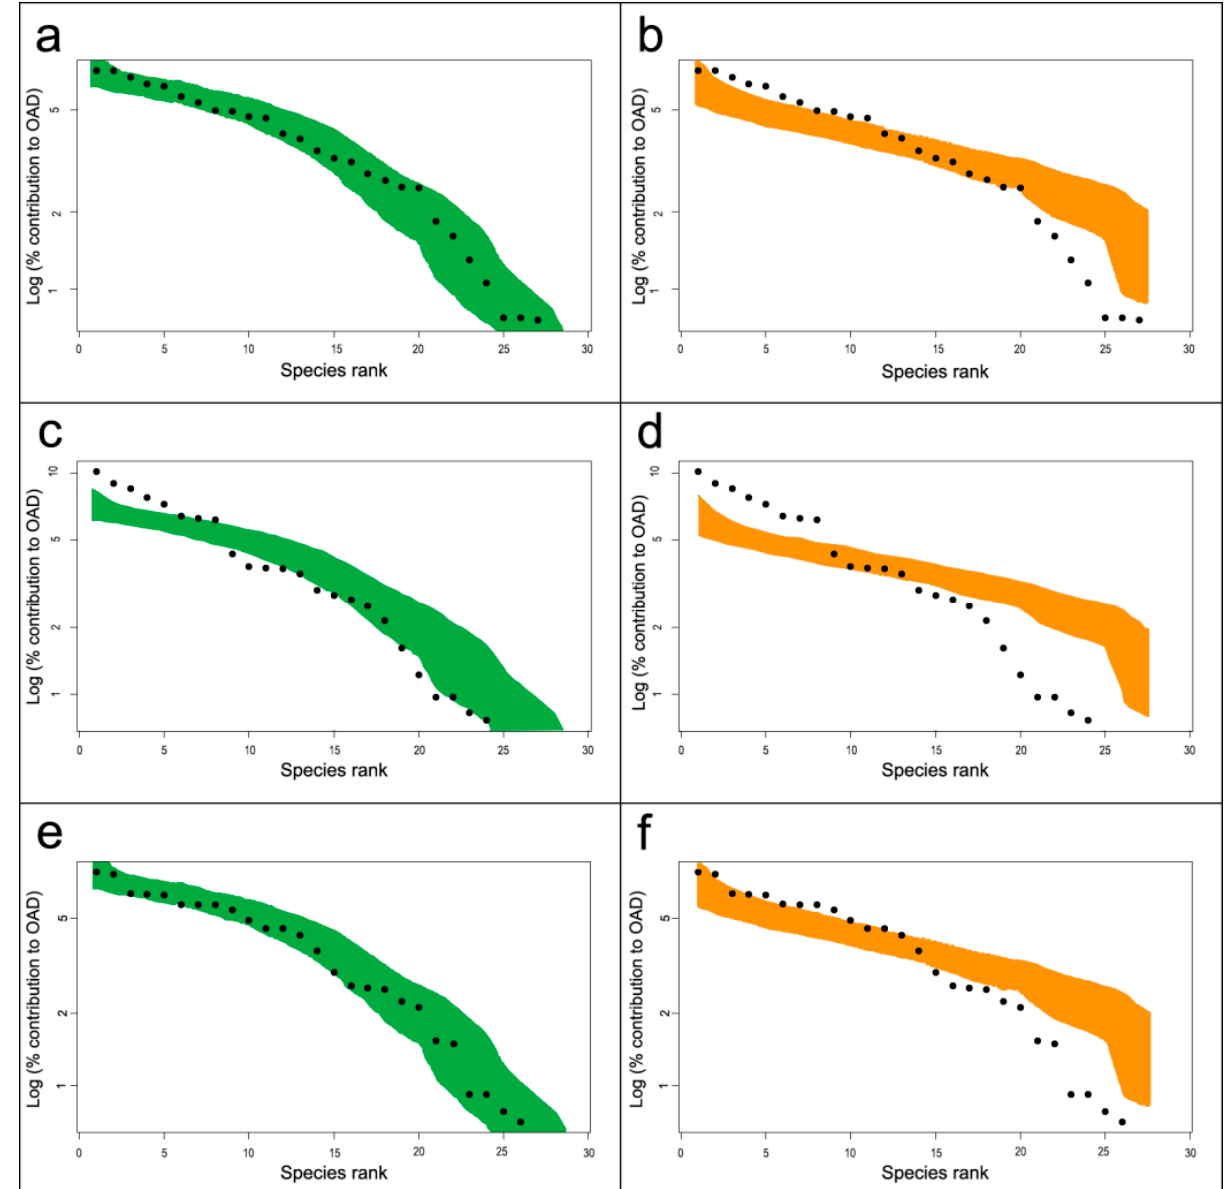
Figure 6. Permutation results comparing the empirical SIMPER profile (black dots) and the null SIMPER profile distributions (95% confidence intervals) for the two permutation models used by the PER-SIMPER analysis for each couple of groups. ( a ) Permutation profile under the null hypothesis H0 1 between sites of Group A and Group B; ( b ) Permutation profile under the null hypothesis H0 2 between sites of Group A and Group B; ( c ) Permutation profile under the null hypothesis H0 1 between sites of Group A and Group C; ( d ) Permutation profile under the null hypothesis H0 2 between sites of Group A and Group C; ( e ) Permutation profile under the null hypothesis H0 1 between sites of Group B and Group C; ( f ) Permutation profile under the null hypothesis H0 2 between sites of Group B and Group C.